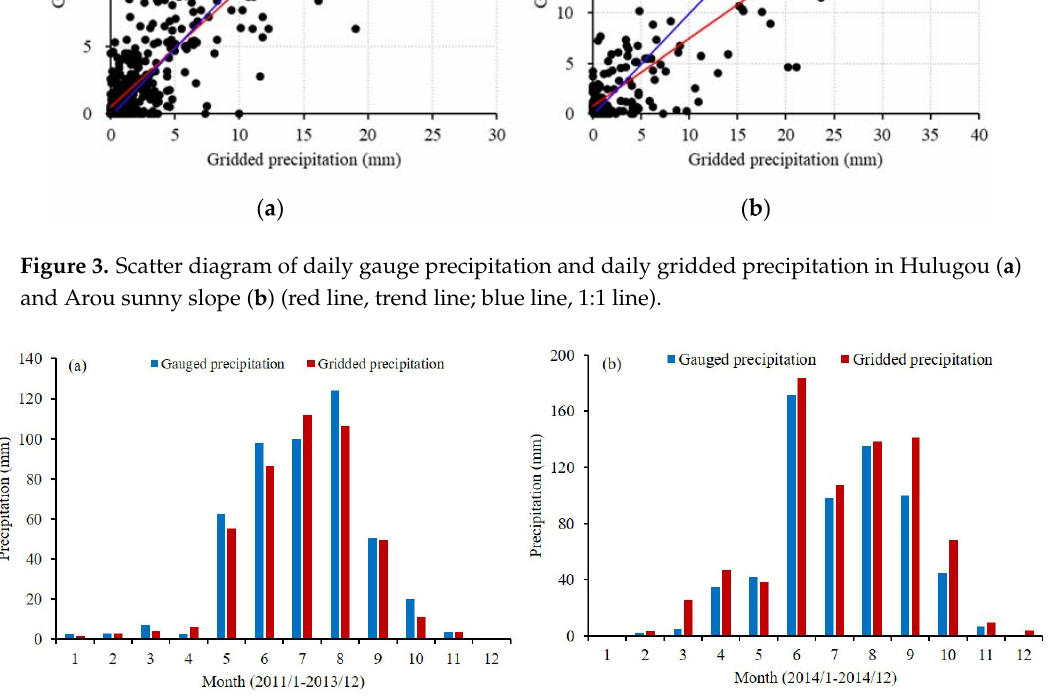
Figure 4. Comparison of monthly gauge precipitation and gridded precipitation in Hulugou ( a ) and Arou sunny slope ( b ).